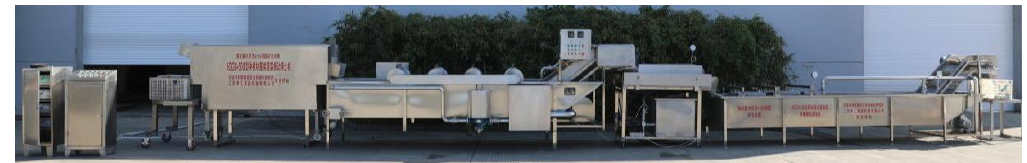
Figure 9. Equipment of cleaning test.